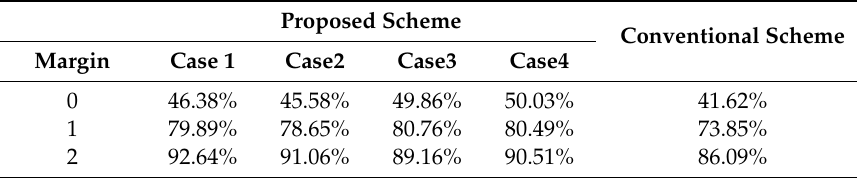
Table 4. Simulation results.